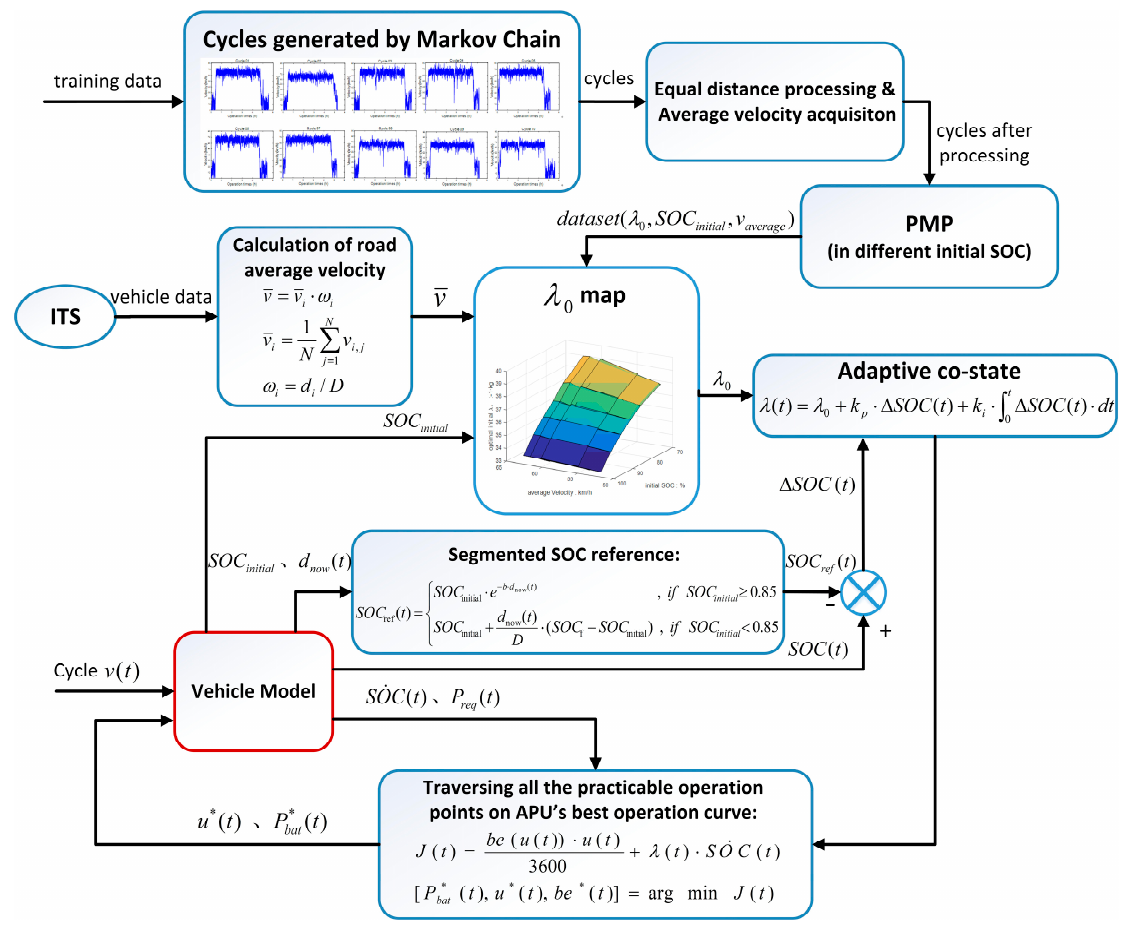
Figure 11. The architecure of A-ECMS.